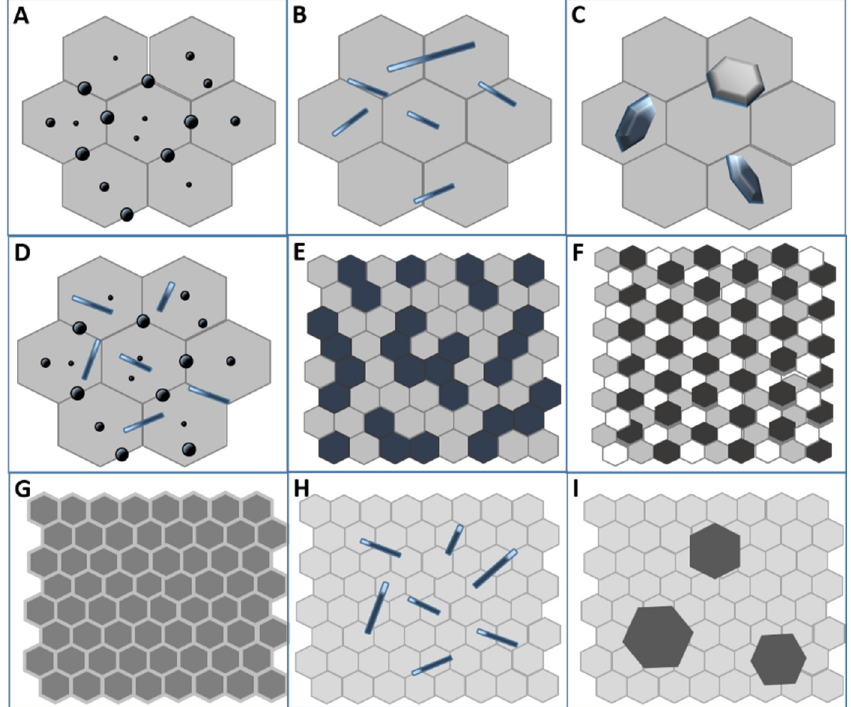
Figure 2. Scheme of common (nano)composite structures for ceramic materials, redrafted from [4] and [5]. ( a ) Micro/nano composite, with rounded nanoparticles occupying both inter- and intra-granular positions inside a micronic matrix; ( b ) Micro/nano composite, with elongated nanoreinforcements embedded in a micronic matrix; ( c ) Micro/nano composite, with platelet-like nanoreinforcements embedded in a micronic matrix; ( d ) Micro/nano composite, containing both rounded and elongated nanoreinforcements, embedded in a micronic matrix; ( e ) Bi-phasic composite made by two immiscible ultra-fine phases; ( f ) Multi-phasic composite made by three (or more) immiscible nanophases; ( g ) Nano/nanolayer type composite; ( h ) Nano- or micro-fibers embedded in a fine matrix; ( i ) Large second-phase precipitates embedded in a fine